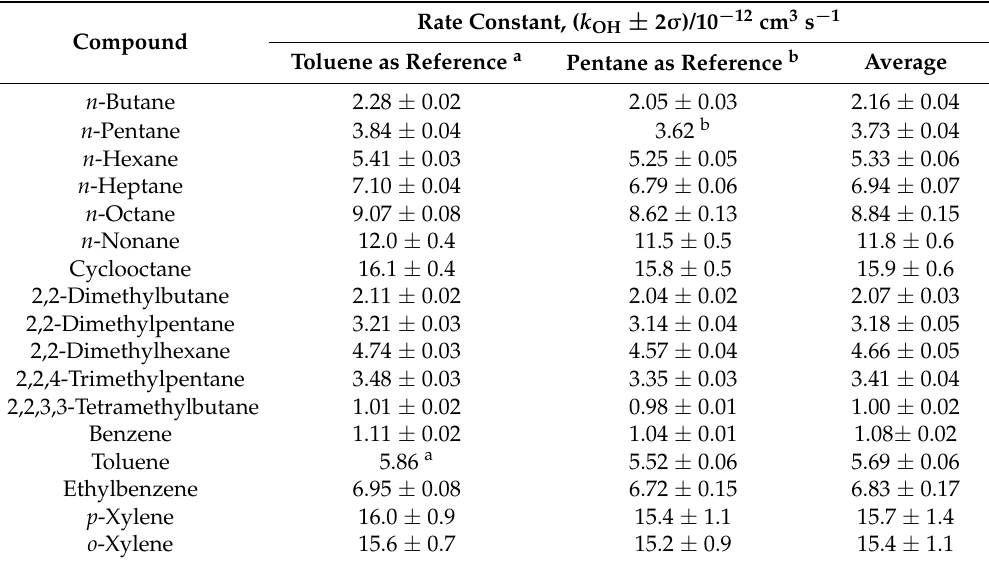
Table 1. Rate constants for the reaction of OH radicals with hydrocarbons at 288